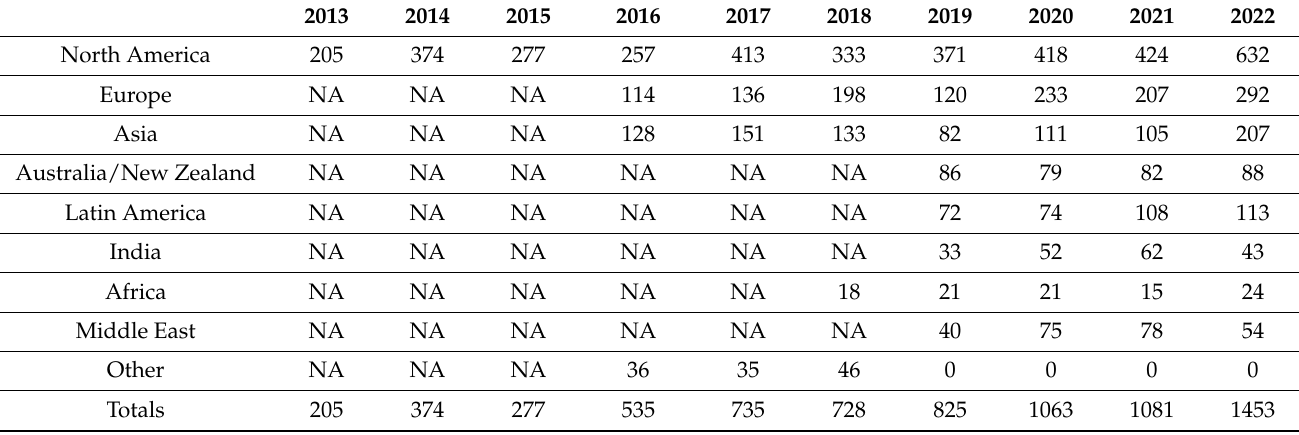
Table 1. Sample by Geographic Region and Survey Year.